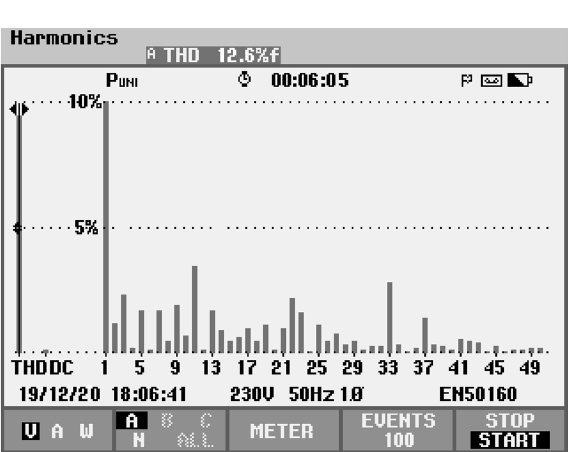
Figure 10. Experimental voltage THD spectrum.